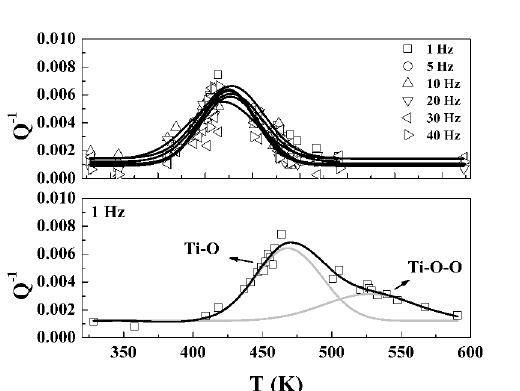
Figure 2. Peak decomposition of the Ti-15Zr-10Mo alloy.